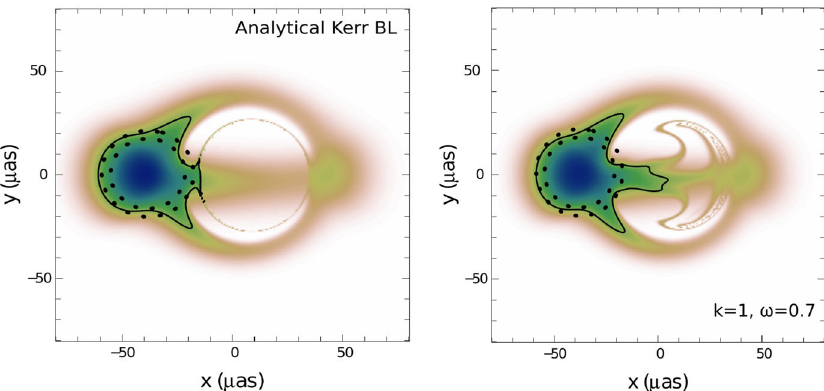
Fig. 30 Computed images as might be expected from the EHT for: (left) a Kerr black hole and (right) a fast spinning boson star with accretion according to certain assumptions. The similarity in images indicates that ruling out a BS candidate in images of Sgr A* may prove dif fi cult. Reproduced with permission from Vincent et al. (2016b), copyright by